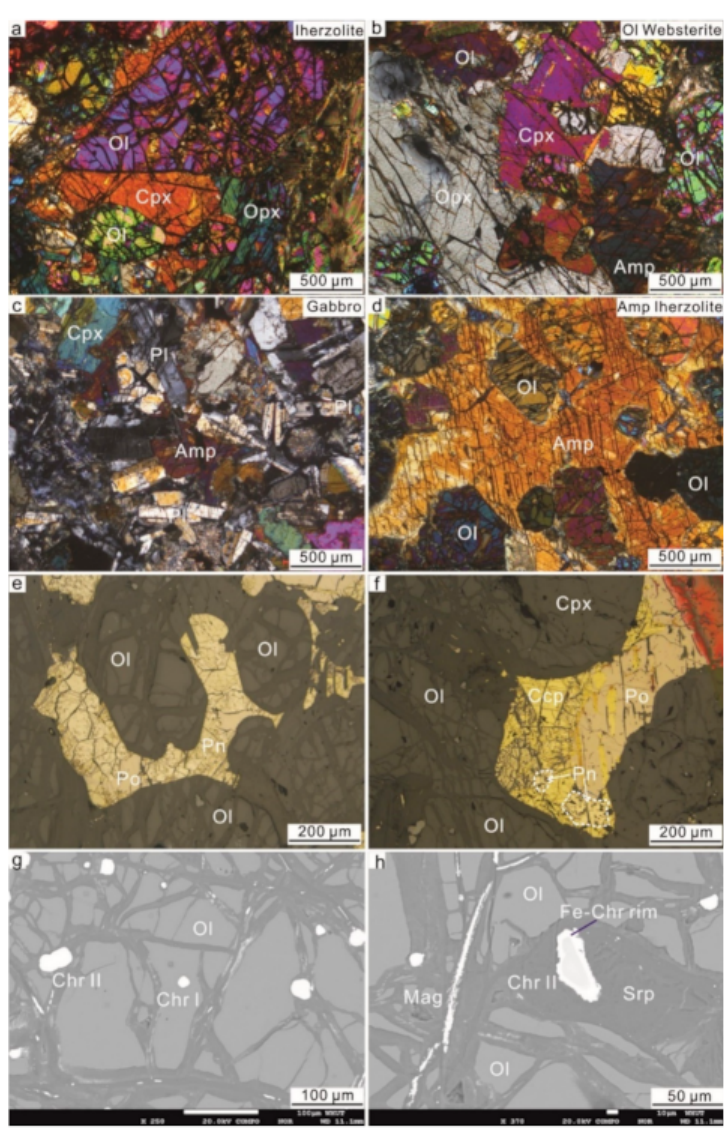
Figure 3. Photomicrographs of mafic-ultramafic rocks showing the occurrence of silicate minerals, sulfide, and chromite: ( a ) lherzolite, rounded olivine encased in clinopyroxene; ( b ) olivine websterite; ( c ) gabbro, with slight alteration of silicate minerals; ( d ) amphibole lherzolite, widespread amphibole enveloping olivine grains and exhibiting two groups of complete cleavage; ( e , f ) interstitial sulfide of pentlandite, pyrrhotite, and chalcopyrite occurring between silicate minerals; and ( g ) two types of chromite. Type I chromite occurs as inclusions enclosed in olivine (Chr I). Type II chromite occurs as interstitial phase in serpentine (Chr II). ( h ) A few type II chromites display zonation with bright